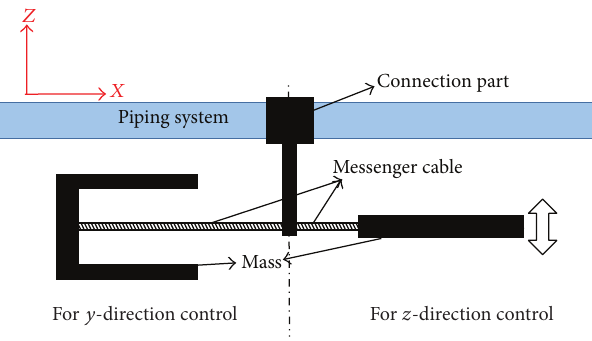
Figure 5: Components of a Stockbridge damper.